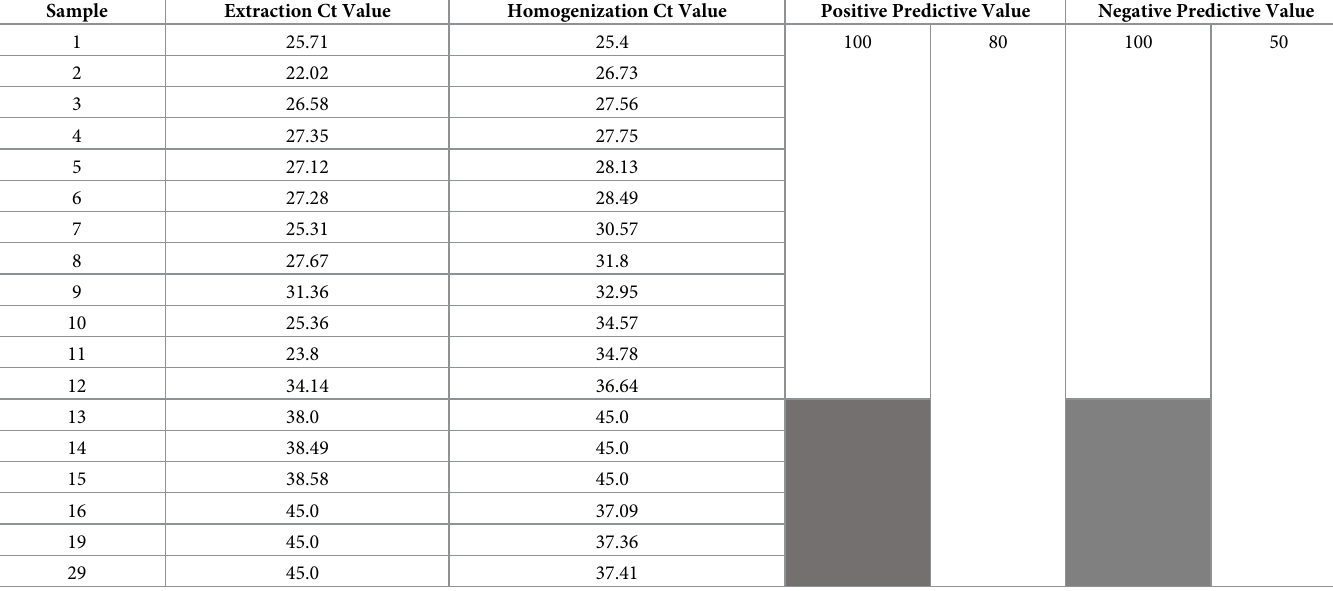
Table 2. RT-qPCR results displayed as Ct values for patients with positive SARS-CoV-2 detection utilizing either the extraction-based or homogenization-based